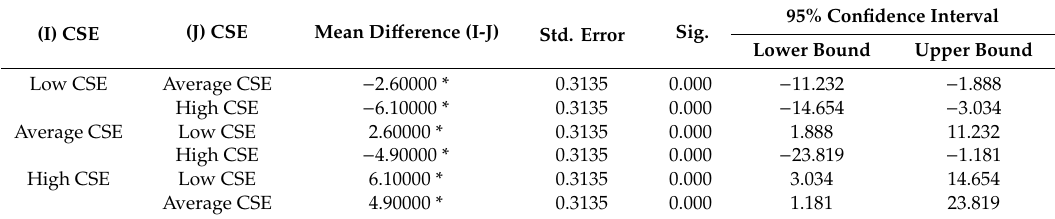
Table 1. ANOVA Table—Core personality traits substantiating self-evaluation (CSE) on self-leadership. Sum of Squares df Mean Square F Sig. Between Groups 98.433 2 48.673 Within Groups 16.112 114.555 Table 2. Post-hoc test—CSE on self-leadership.